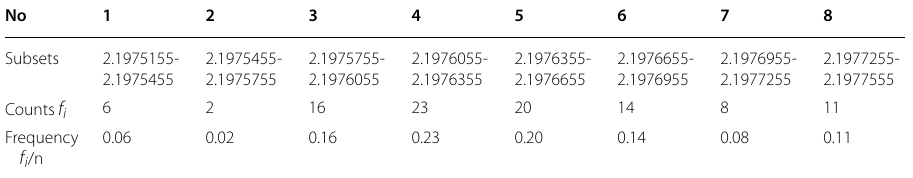
Table 2 Statistical parameters of the samples of fractal